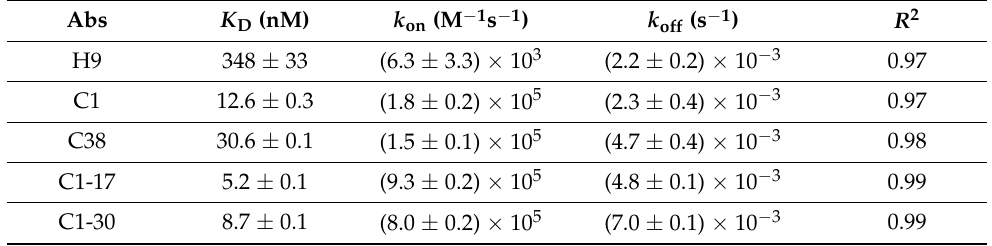
Figure 1. Evaluation of H9 binding to the cell surface-displayed CMVpp65 495-503 /HLA-A*02:01 complex. ( A ) Flow cytometric analysis of the cell surface expression levels of human leukocyte antigen (HLA)-A*02:01, classified as + + (high level) for both MDA-MB-231 and Malme-3M cells, as + (positive) for HCT116 cells, and as - (negative) for LoVo cells. ( B , C ) Flow cytometric analysis of H9 binding at 500 nM (B) to peptide-pulsed cells (B) and at various concentrations to peptide-pulsed MDA-MB-231 cells ( C ). Cells were pulsed with the vehicle, CMVpp65 495-503 peptide (50 µ M), or the control HLA-A*02:01-restricted HPVE7 11-19 (50 µ M) peptide for 3 h at 37 ◦ C and incubated with H9 and then the Alexa Fluor 647-conjugated goat anti-mouse immunoglobulin G (IgG)-specific (Fab’) 2 antibody (Ab) (secondary Ab) prior to flow cytometry. In (A–C), representative histograms from two independent experiments are depicted. Table 1. Parameters of binding kinetics of TCR-like Abs in relation to the CMVpp65 495-503 /HLA- A*02:01 SCT protein, as measured using biolayer